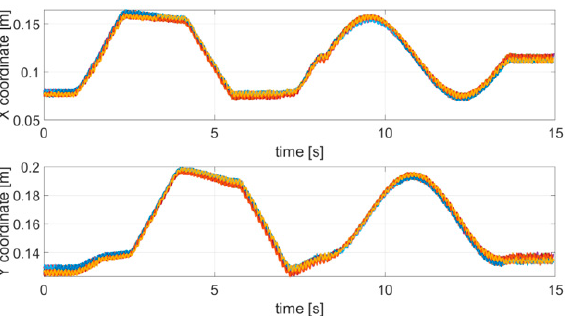
Figure 4. Acquired trajectories (x and y coordinates) for each tremor test carried out.